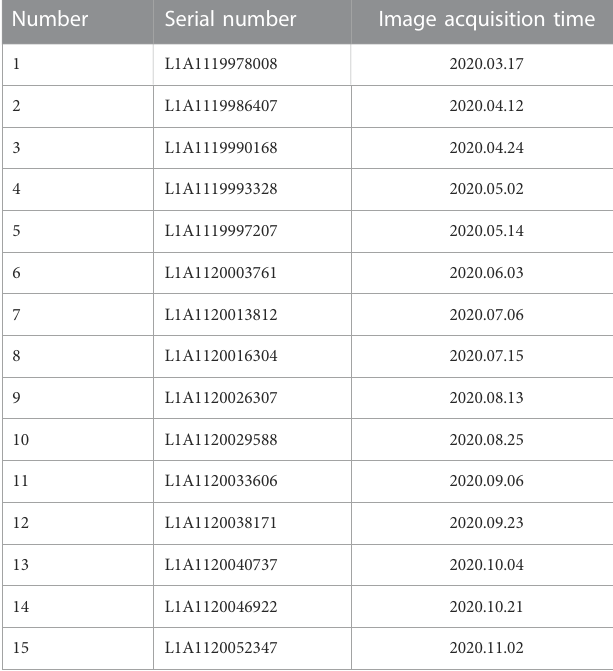
TABLE 1 Parameters of remote sensing image